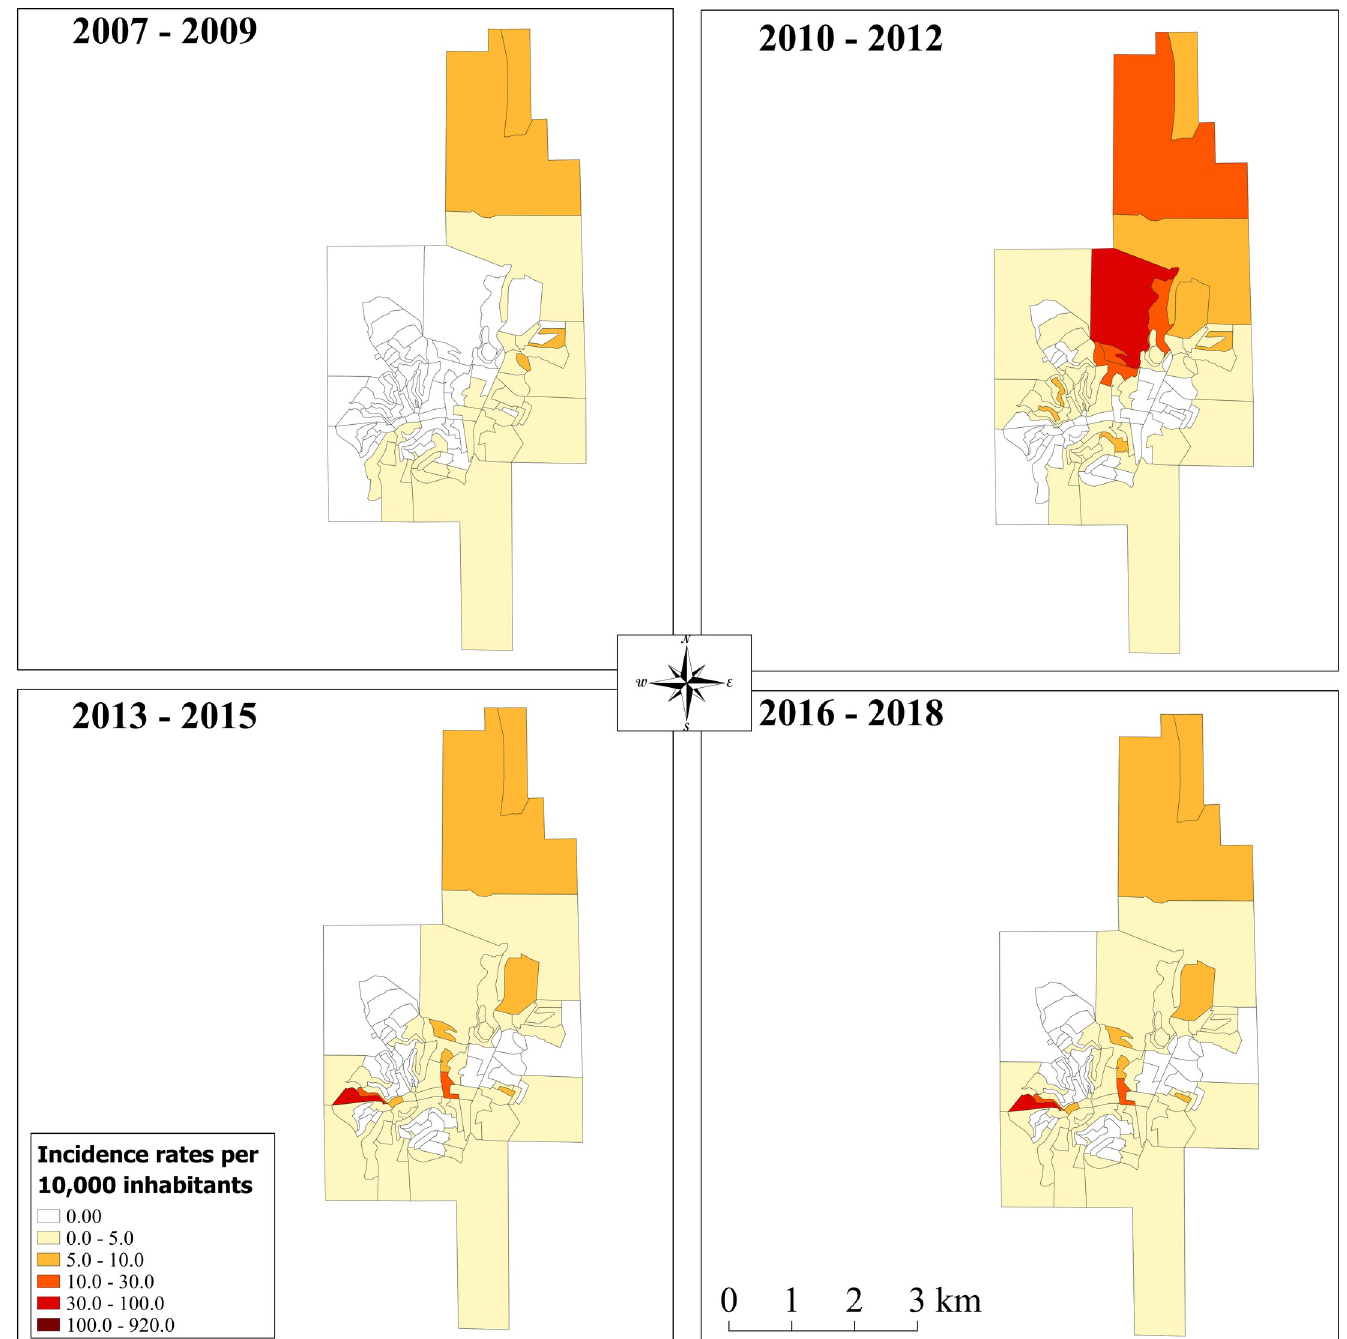
Fig 4. Smoothed Accumulated Incidence, per 10,000 inhabitants, of ATL cases belonging to the urban area of Caratinga